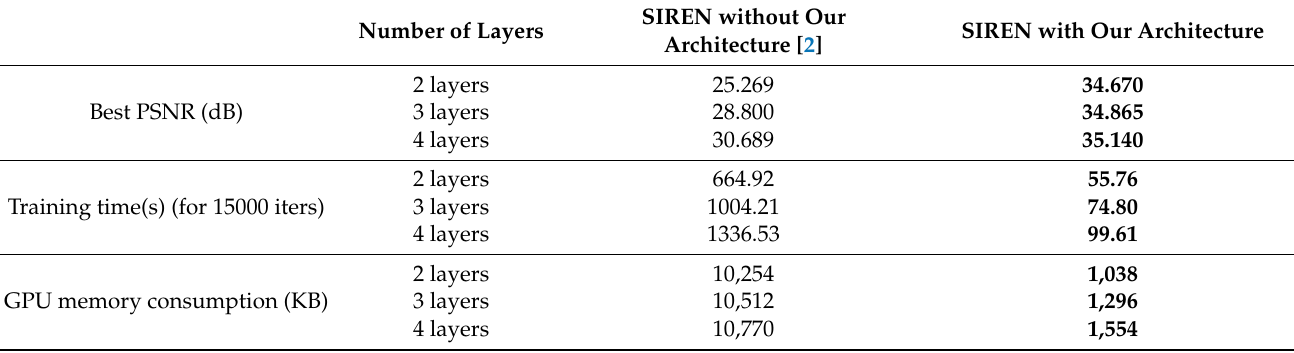
Table 6. Display and comparison of the final results that were obtained using SIREN in the Ref. [2] and using SIREN with our architecture. As it can be seen, using SIREN with our architecture outperforms using SIREN in the Ref. [2] in three terms of quality, speed, and GPU memory allocation with 2, 3 and 4 MLP layers.